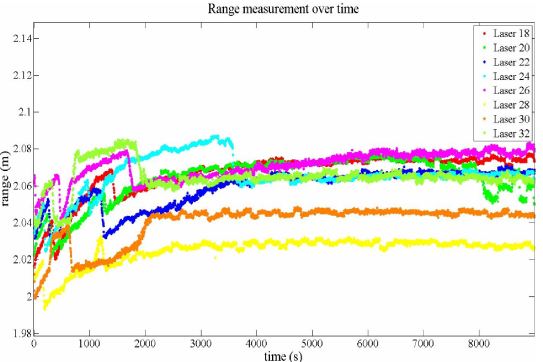
Figure 4. Range measurement for a fixed distance over 9000 seconds (Lasers: 18, 20, 22, 24, 26, 28, 30 and